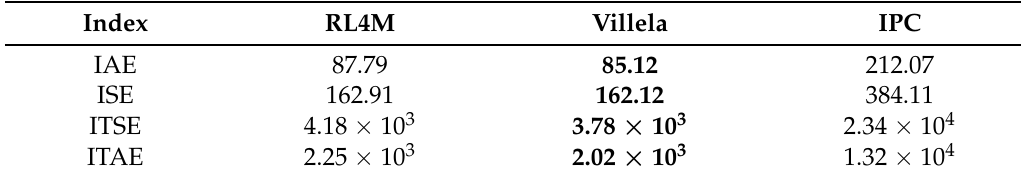
Table 3. Performance indexes for each algorithm in the path-following experiment. In bold, the bet- ter case.